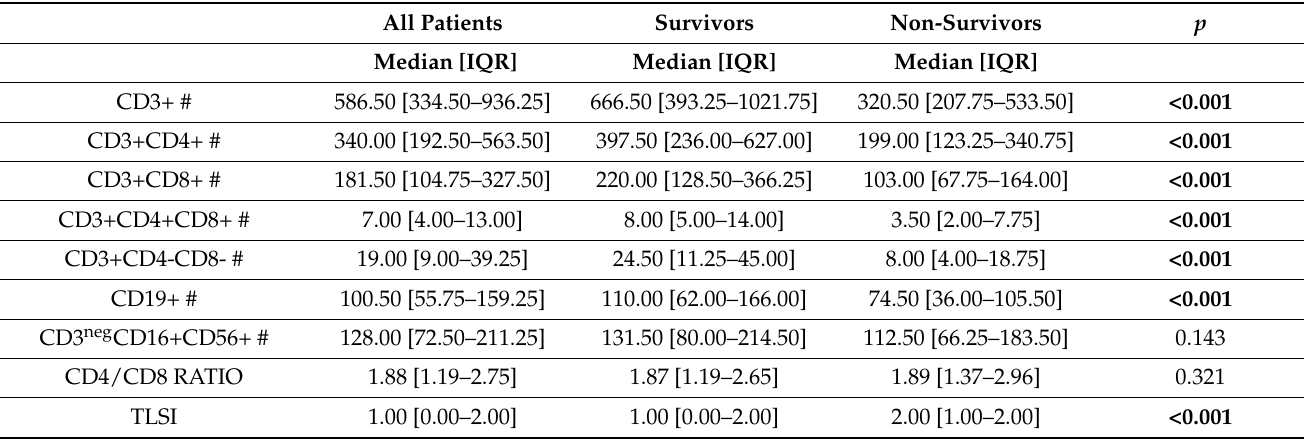
Table 3. T-, B-, and NK-lymphocyte subpopulation absolute counts at hospitalization in the study cohort, overall and after stratification for outcome (survivors and